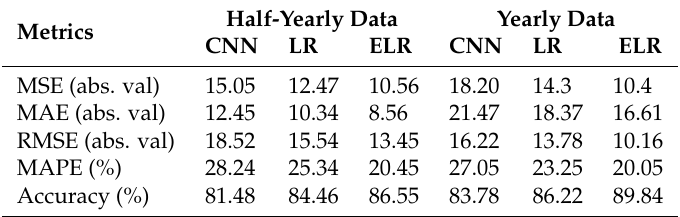
Table 19. Load performance metrics comparison for one day using the UCI Dataset.